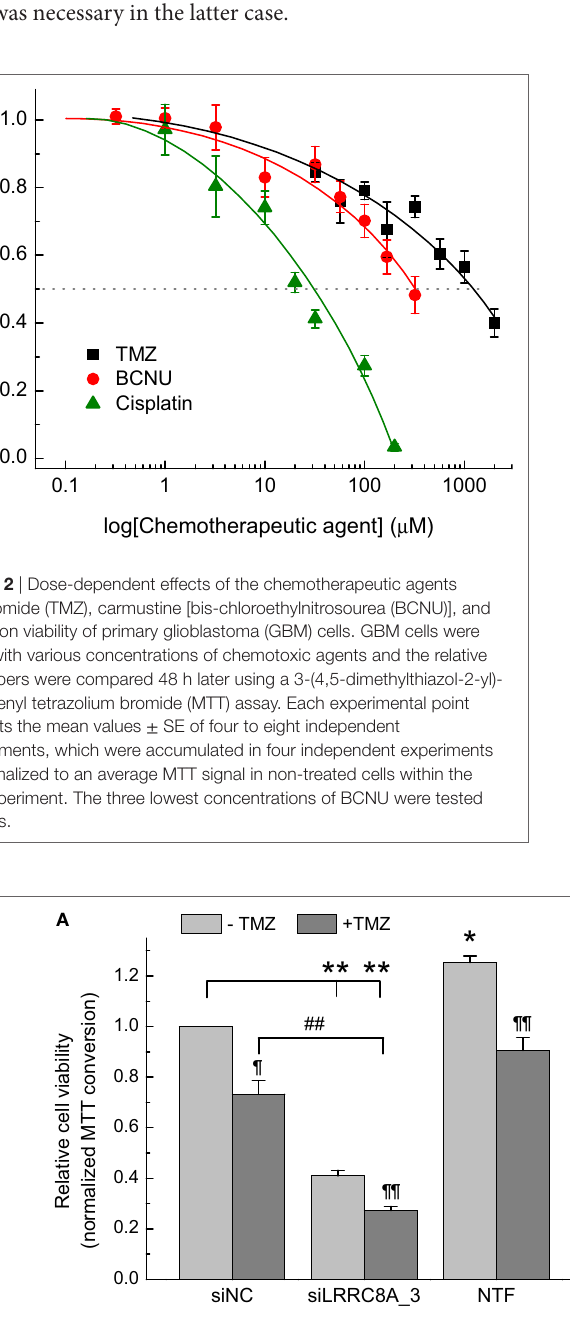
FigUre 3 | Effects of temozolomide (TMZ) and leucine-rich repeat-containing 8A (LRRC8A) siRNA on viability and proliferation of glioblastoma (GBM) cells determined by 3-(4,5-dimethylthiazol-2-yl)-2,5-diphenyl tetrazolium bromide (MTT) (a) or Coulter counter (B) assays. GBM cells were transfected with siLRRC8A_3 or negative control siRNA (siNC). 48 h post-transfection cells were additionally treated with 570 µM TMZ. Relative levels of cell proliferation were determined 48 h after addition of TMZ (96 h post-transfection with siRNA). Non-transfected cells (NTF) were used in MTT assays as an additional internal control. The data are the mean values ± SE of three independent experiments performed in triplicates ( n = 3) for MTT assays, or four independent transfections ( n = 4) in Coulter counter experiments. * p < 0.05, ** p < 0.01, *** p < 0.001 vs. cells transfected with siNC. ¶ p < 0.05, ¶¶ p < 0.01, ¶¶¶ p < 0.001, within the group effect of TMZ vs. siRNA or mock treatment alone. ## p < 0.01, ### p < 0.001, TMZ effect in cells treated with siNC vs. cells treated with